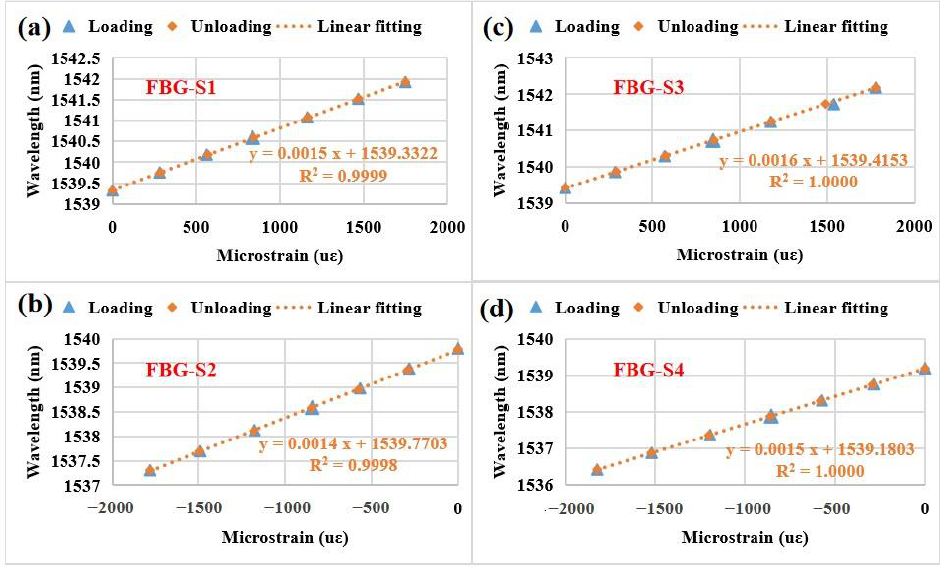
Figure 11. Central wavelengths of the four FBG strain sensors as a function of microstrains during